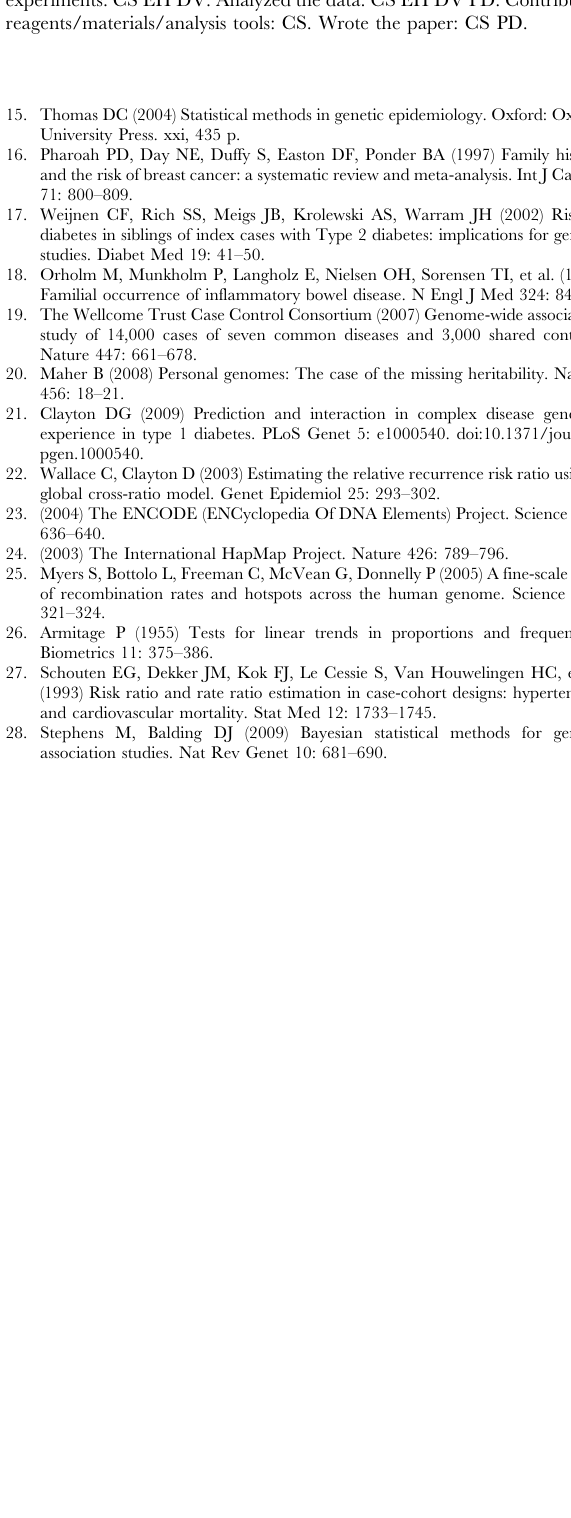
Table S5 Replicated SNPs for breast cancer. (See main text for